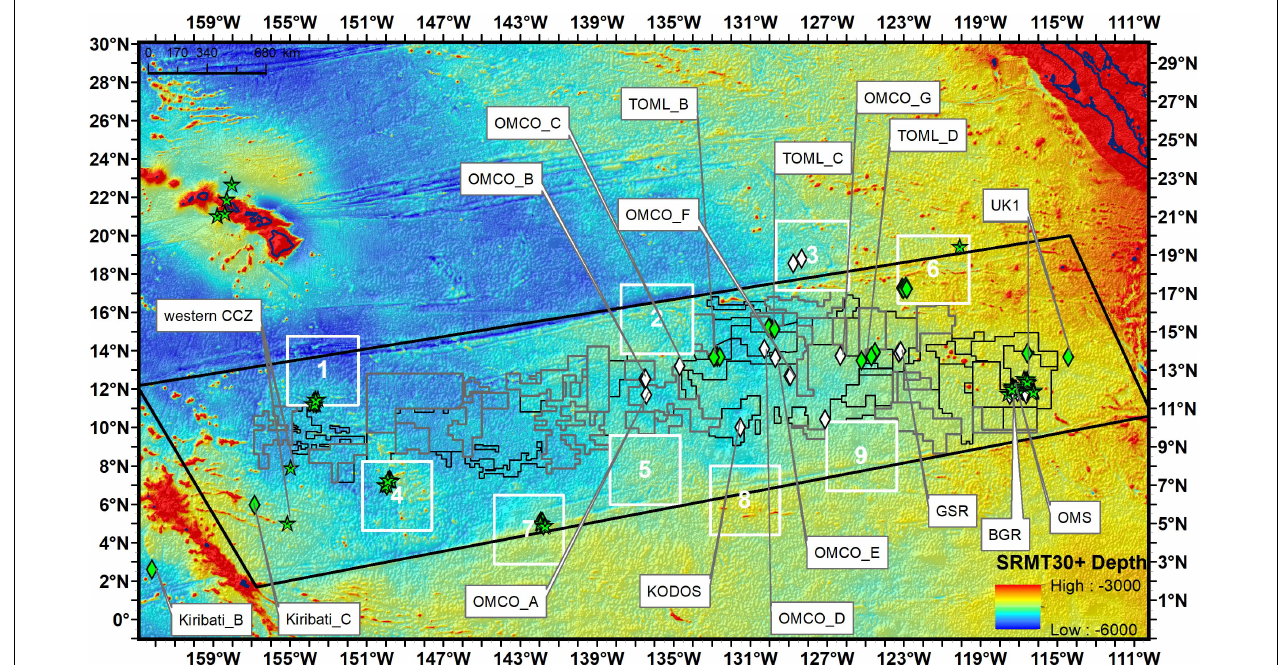
FIGURE 2 | Locations of visual transects (diamonds) and baited camera sample (stars) locations across the CCZ. Quantitative visual transects are in green and non-quantitative in white symbols. Study locations are given as abbreviations (see Table 1 ).